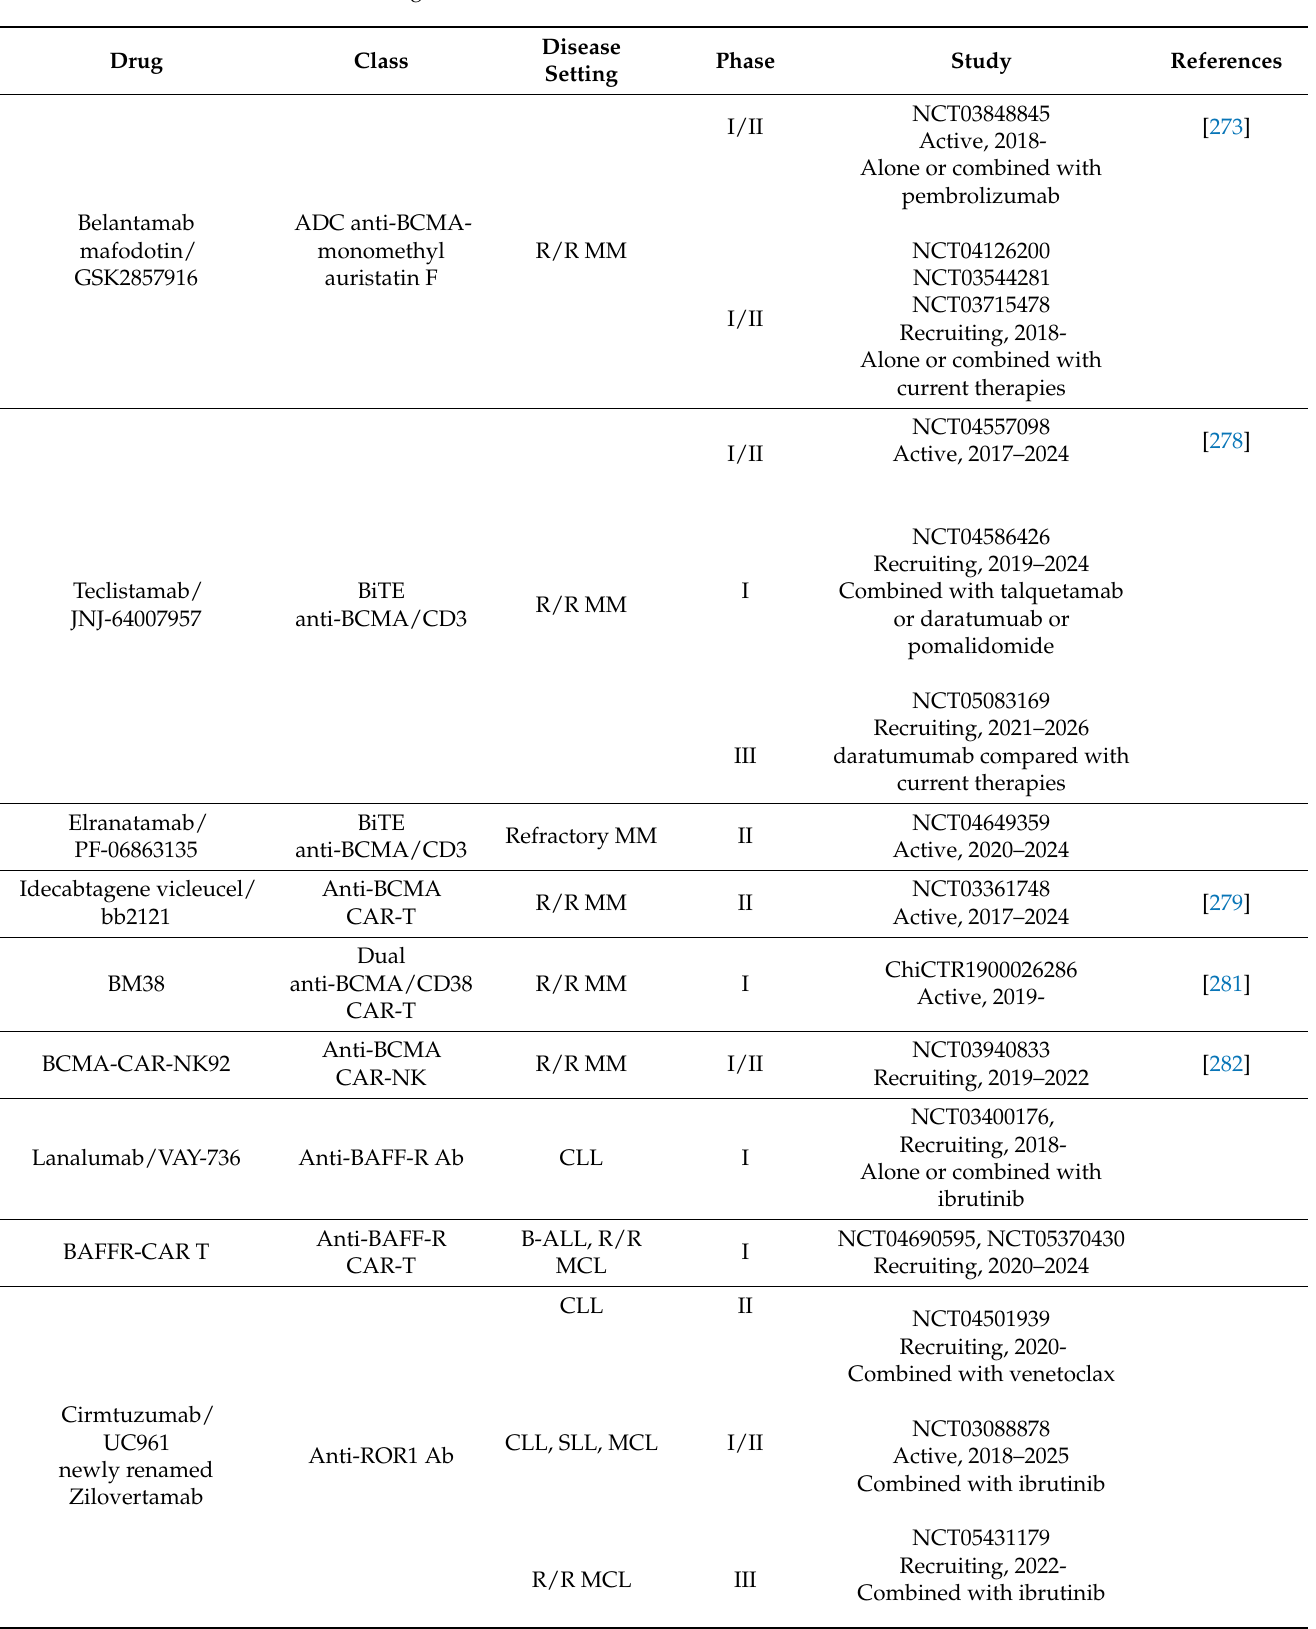
Table 4. Selected ongoing and now-recruiting clinical trials of novel anti-TAA inhibitors in B cell